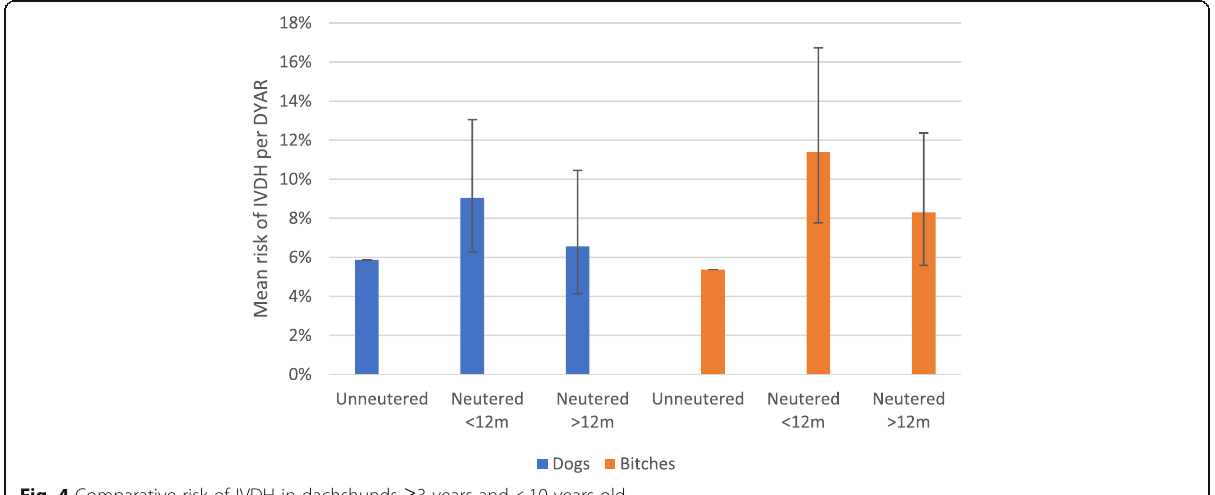
Fig. 4 Comparative risk of IVDH in dachshunds ≥ 3 years and < 10 years old